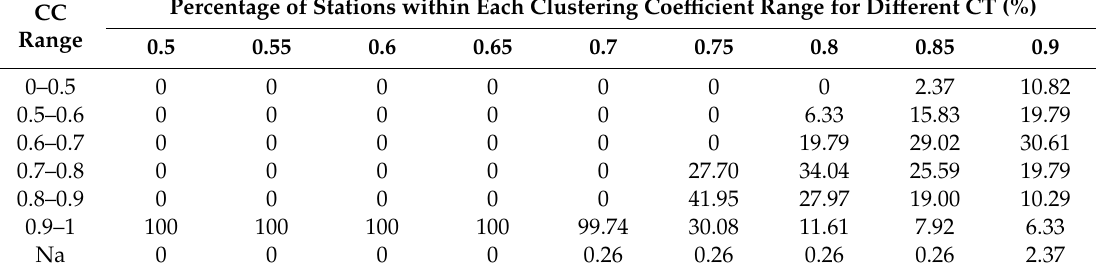
Figure 3. Clustering coefficient values of the S-network for nine threshold values. Table 2. Clustering coefficient values for different thresholds (S-network).